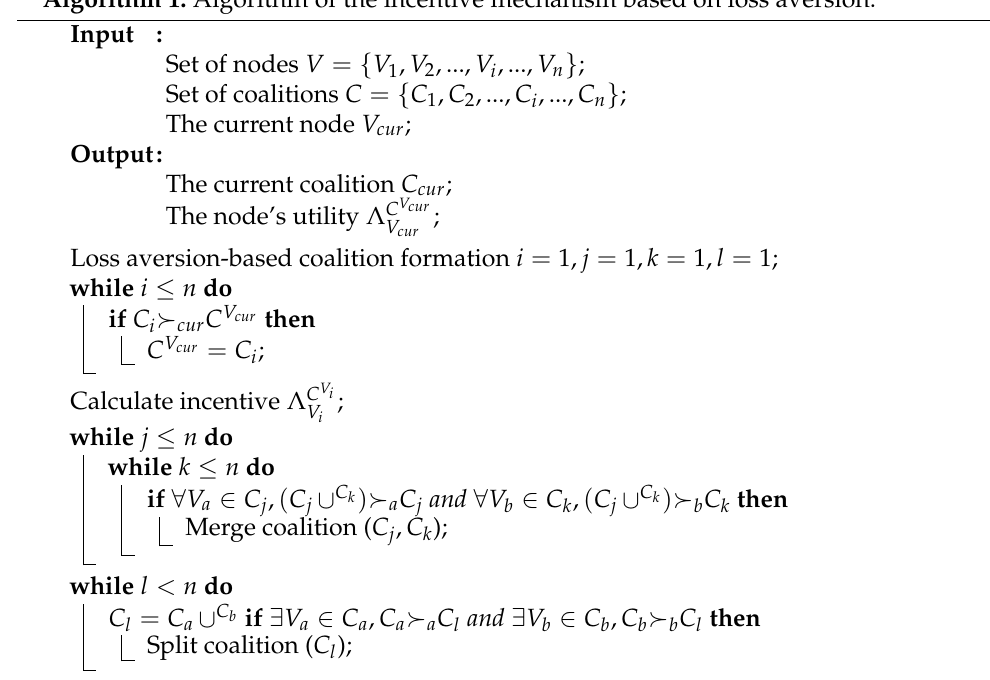
Algorithm 1: Algorithm of the incentive mechanism based on loss